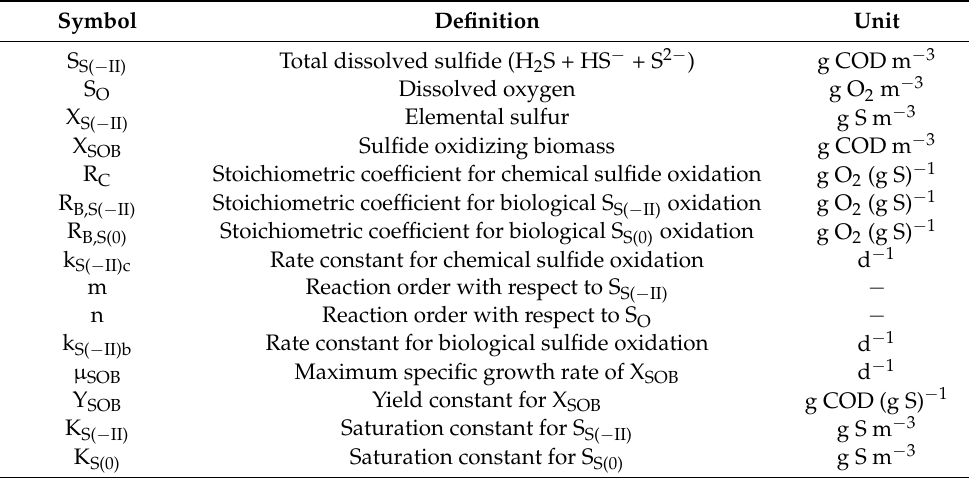
Table 2. Kinetic and stoichiometric parameters used in the process model outlined in Table